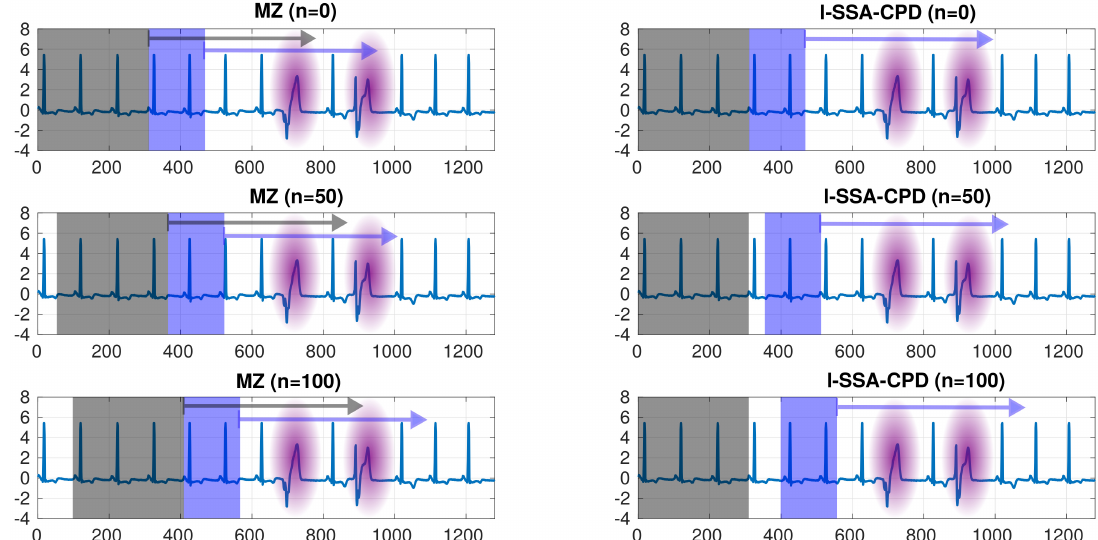
Figure 2. Comparison of MZ (left) and l-SSA-CPD (right). The computational burden of l-SSA-CPD is greatly reduced compared to MZ by relying on the reference subspace obtained from an initial, non-sliding trajectory matrix (illustrated by the gray background area). Furthermore, note that l-SSA-CPD’s reference subspace remains locked on the main signal’s characteristics while in MZ, since the reference subspace is updated at each observation (illustrated by the gray area sliding as well), it will lock on the two anomalies (highlighted in pink) for some time as the two moving windows are pass over